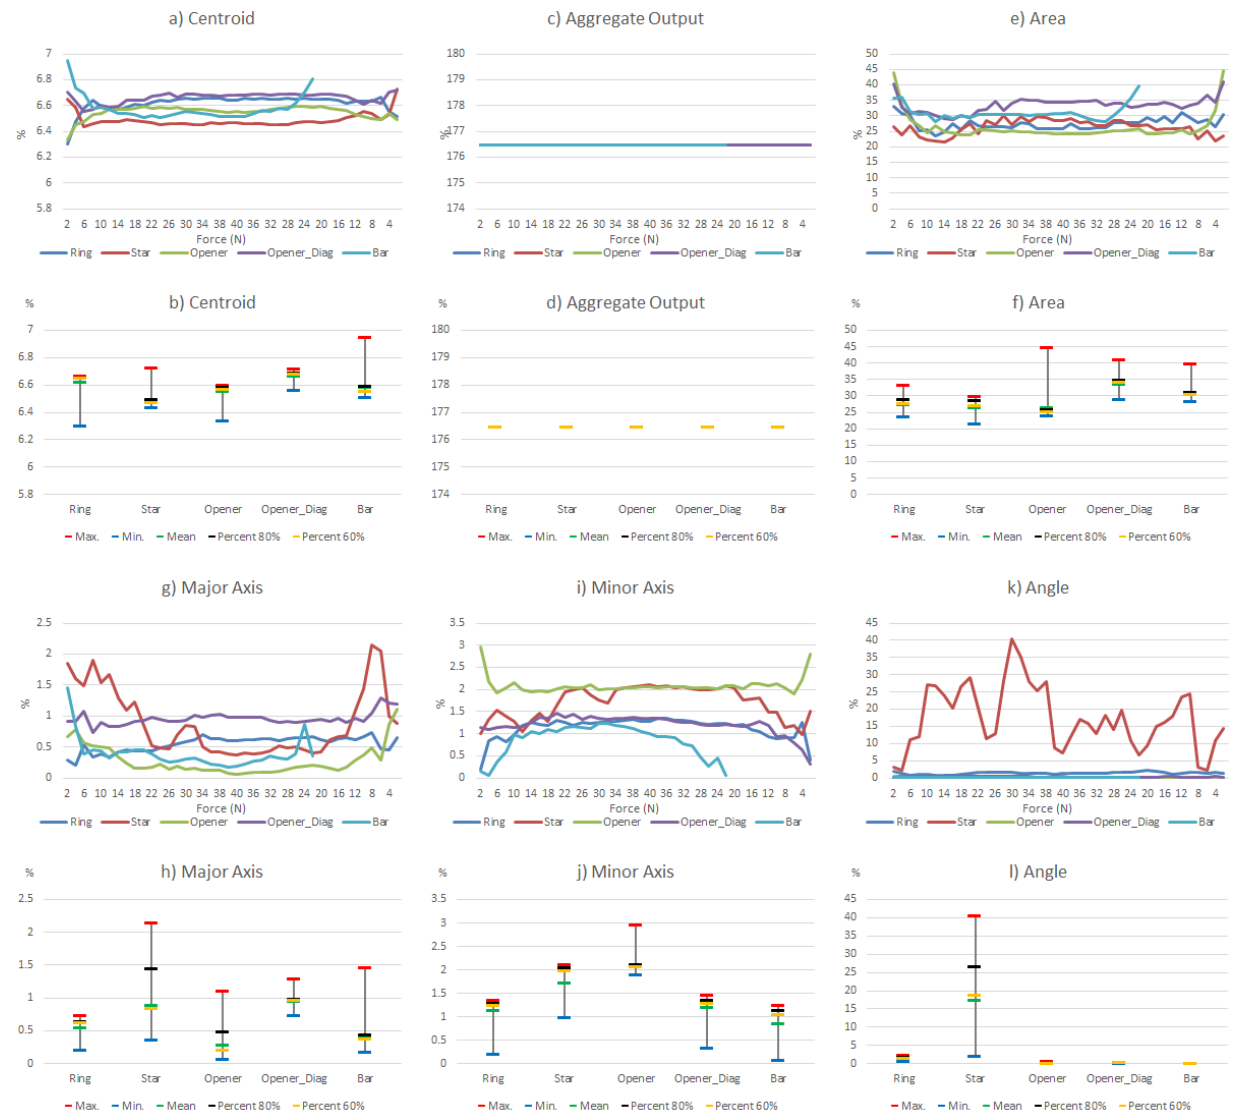
Figure 13. Variations of the system level parameters caused by a 25% decrease of the resolution in tactile images obtained with the commercial